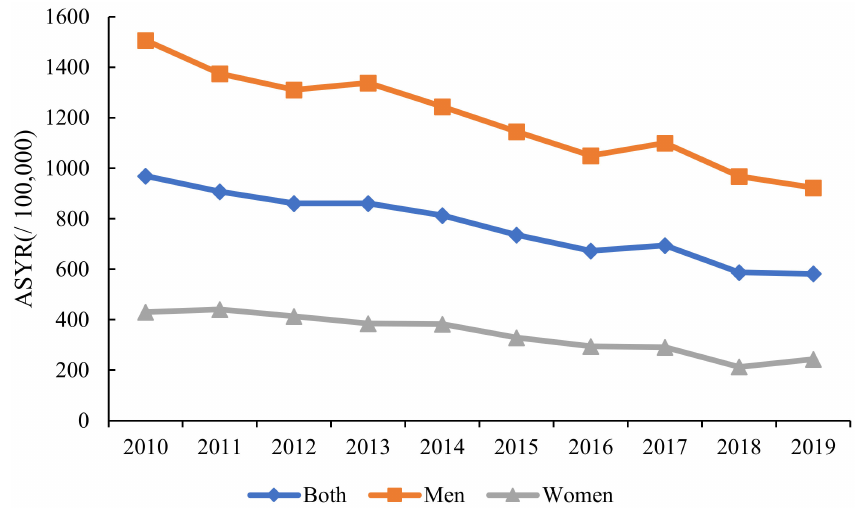
Figure 3. The Trends in the ASYRs of Liver Cancer in Wuhan from 2010 to 2019. Figure 4 shows the ASYRs of districts in Wuhan in 2010 and 2019. Xinzhou, Caidian, and Hannan showed the highest ASYRs in 2010, with an ASYR of 1566.99 per 100,000 people, 1260.20 per 100,000 people, and 1251.97 per 100,000 people, respectively. In 2019, the top three highest districts were Xinzhou, Jiangxia, and Caidian, with ASYRs of 971.88 per 100,000 people, 759.00 per 100,000 people, and 732.60 per 100,000 people,